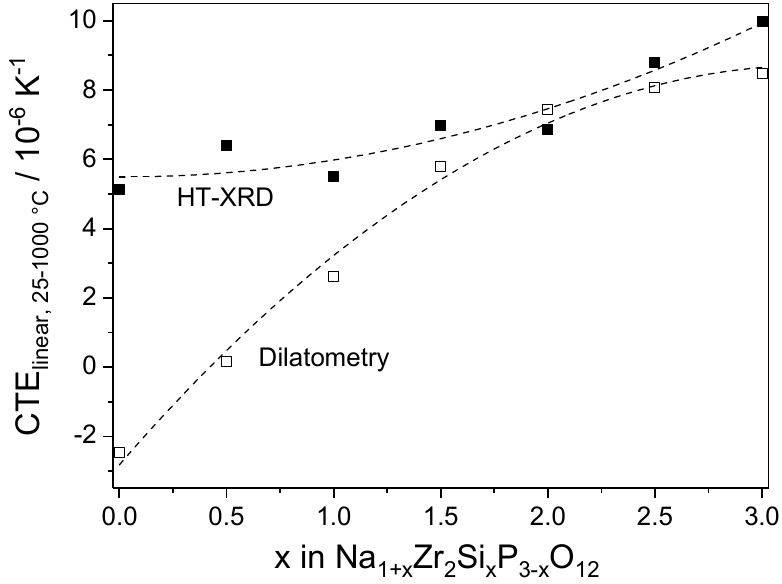
Figure 1. Linear thermal expansion (see Equations (1)–(3)) of NaSICON ceramics measured by dilatometry and HT-XRD during heating [8]. A satisfying agreement of the values is obtained only for x ≥ 1.5.